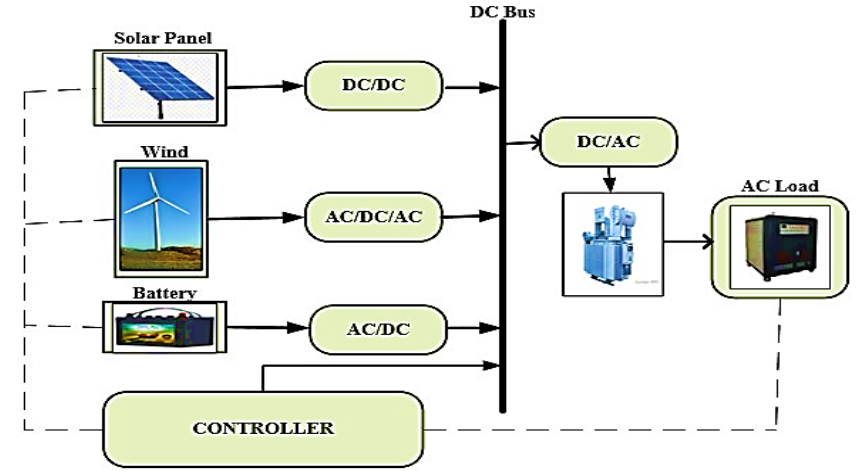
Figure 7. Block diagram of a conventional PV – wind – battery system [56].